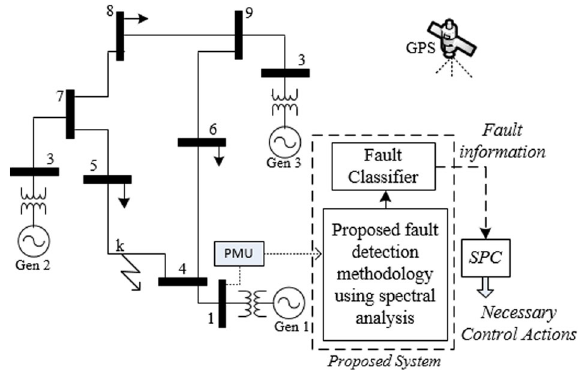
Fig. 2 Proposed fault classification methodology